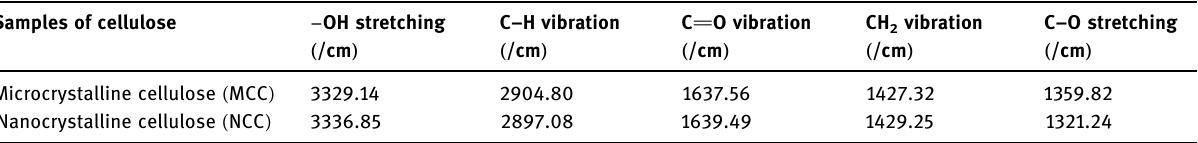
Table 2: Functional groups of MCC and NCC from pineapple leaves Samples of cellulose − OH stretching